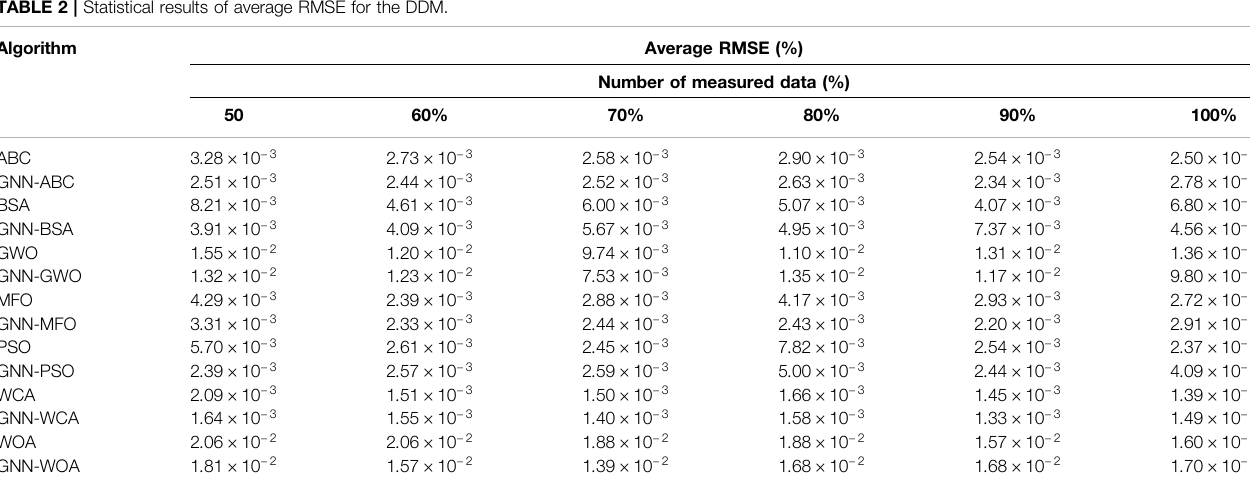
TABLE 2 | Statistical results of average RMSE for the